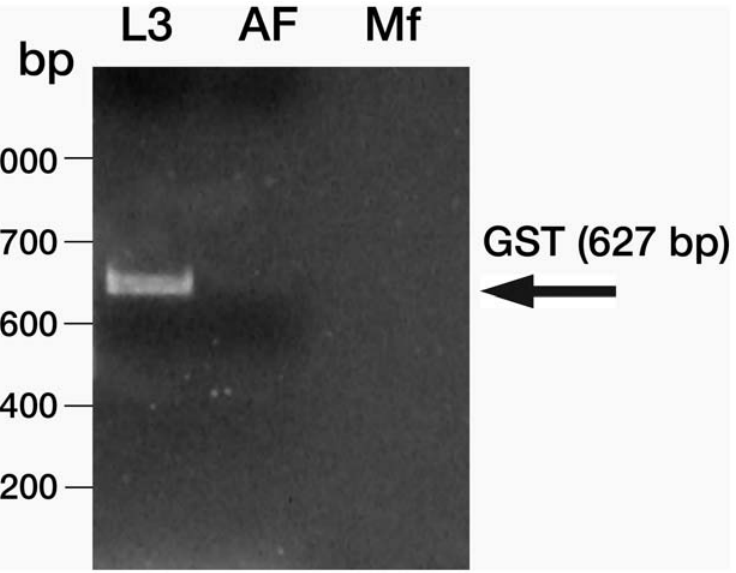
Figure 5. Stage-specific expression of filarial GST . WbGST gene was PCR amplified form W.bancrofti stage-specific cDNA libraries using WbGST gene specific forward and reverse primers. Results show that the WbGST gene is predominantly expressed in the L3 stage of the W.bancrofti and is barely detectable in adult female and microfilarial stages. Lane 1: 100 bp ladder; 2: W. bancrofti L3; 3: Adult Female; and 4: Mf.